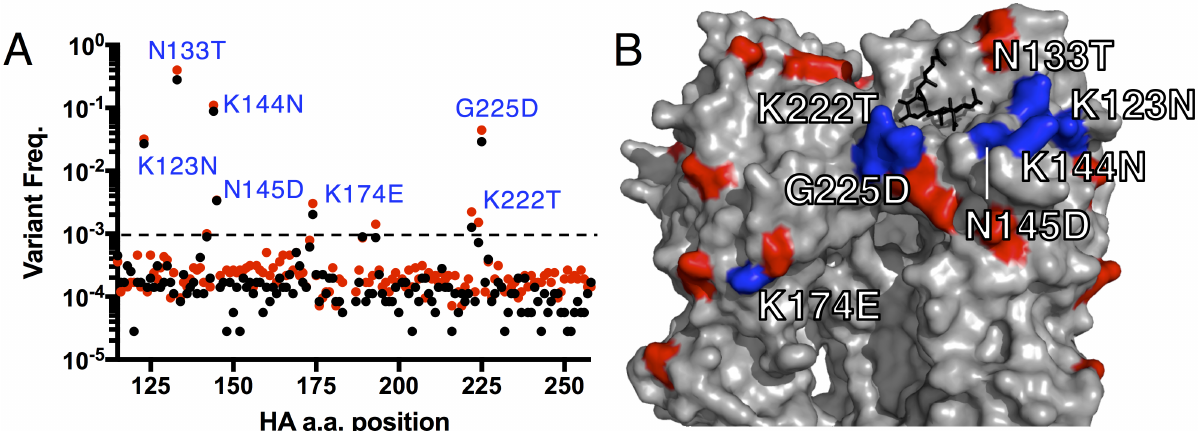
Fig 2. Identification of variants that emerge on the SV12 background after passage in eggs in the absence of antibody. (A) Amino acid variant frequencies within SV12 HA following limited passage in eggs, as determined by primerID sequencing. Red and black data points represent frequencies obtained from two stocks separately expanded one time in eggs prior to sequencing. Amino acid positions with > 0.1% variability (dashed line) in both stocks are labeled with the most abundant substitution at the position. Codons 184–186 were not captured by sequencing. (B) HA structure (PDB 1RU7) with the SV12-defining substitutions (red) and emerging amino acid substitutions (labeled in 2A) (blue) highlighted. The black stick model represents sialic acid situated in the receptor binding pocket.